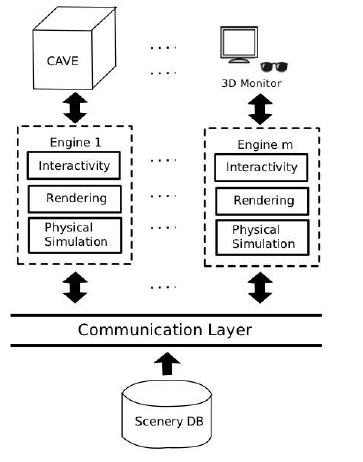
Figure 3. Computing Platform